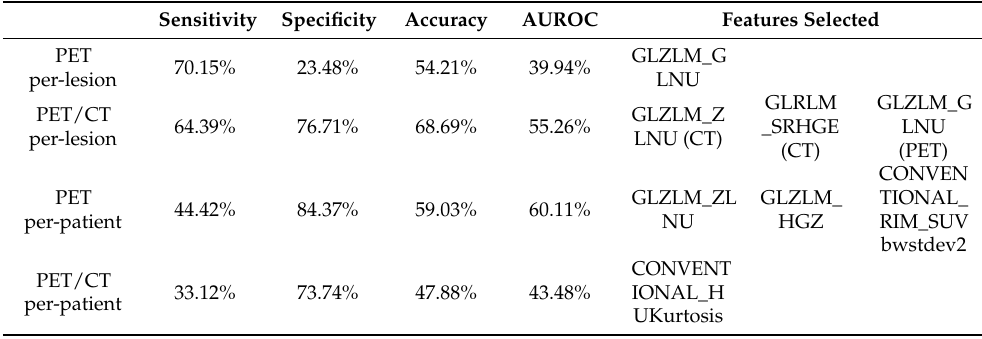
Table 3. Radiomics features performance for liver lesions in prediction of disease progression per- patient and per-lesion analysis.